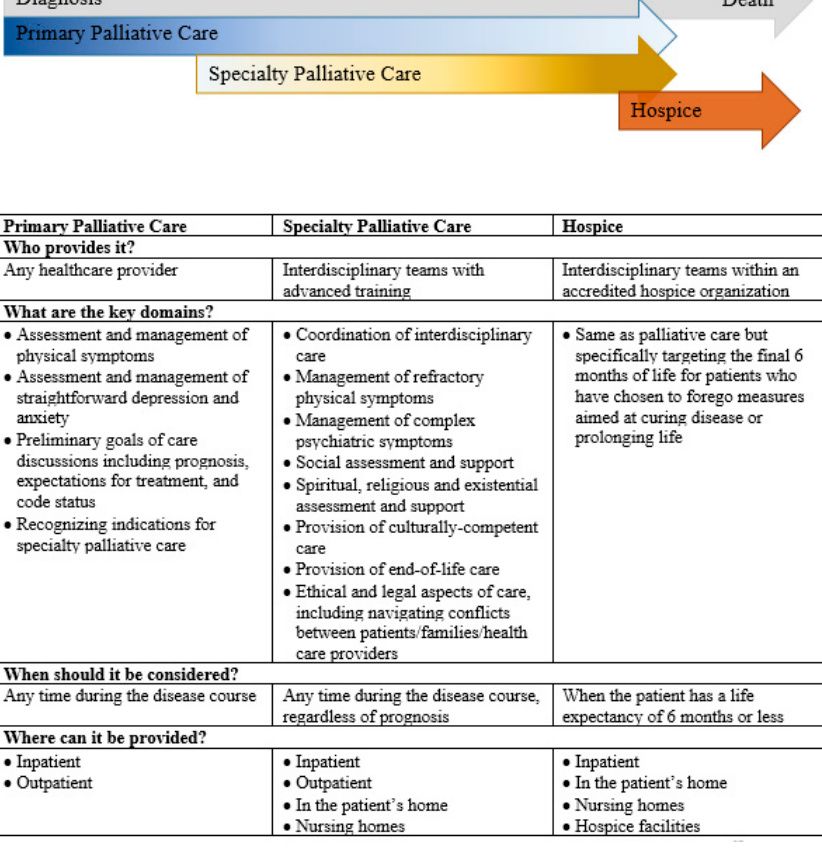
Figure 1. Key differences between primary palliative care, specialty palliative care, and hospice [59,67].